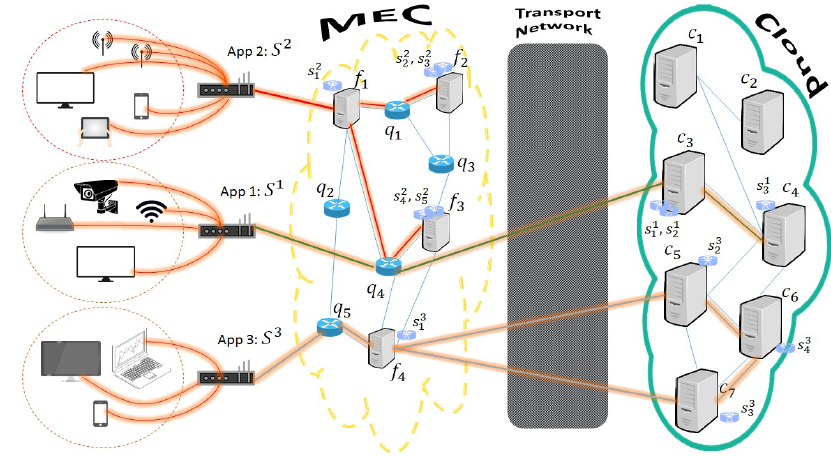
Figure 3. VNF Placement at the Edge and Cloud